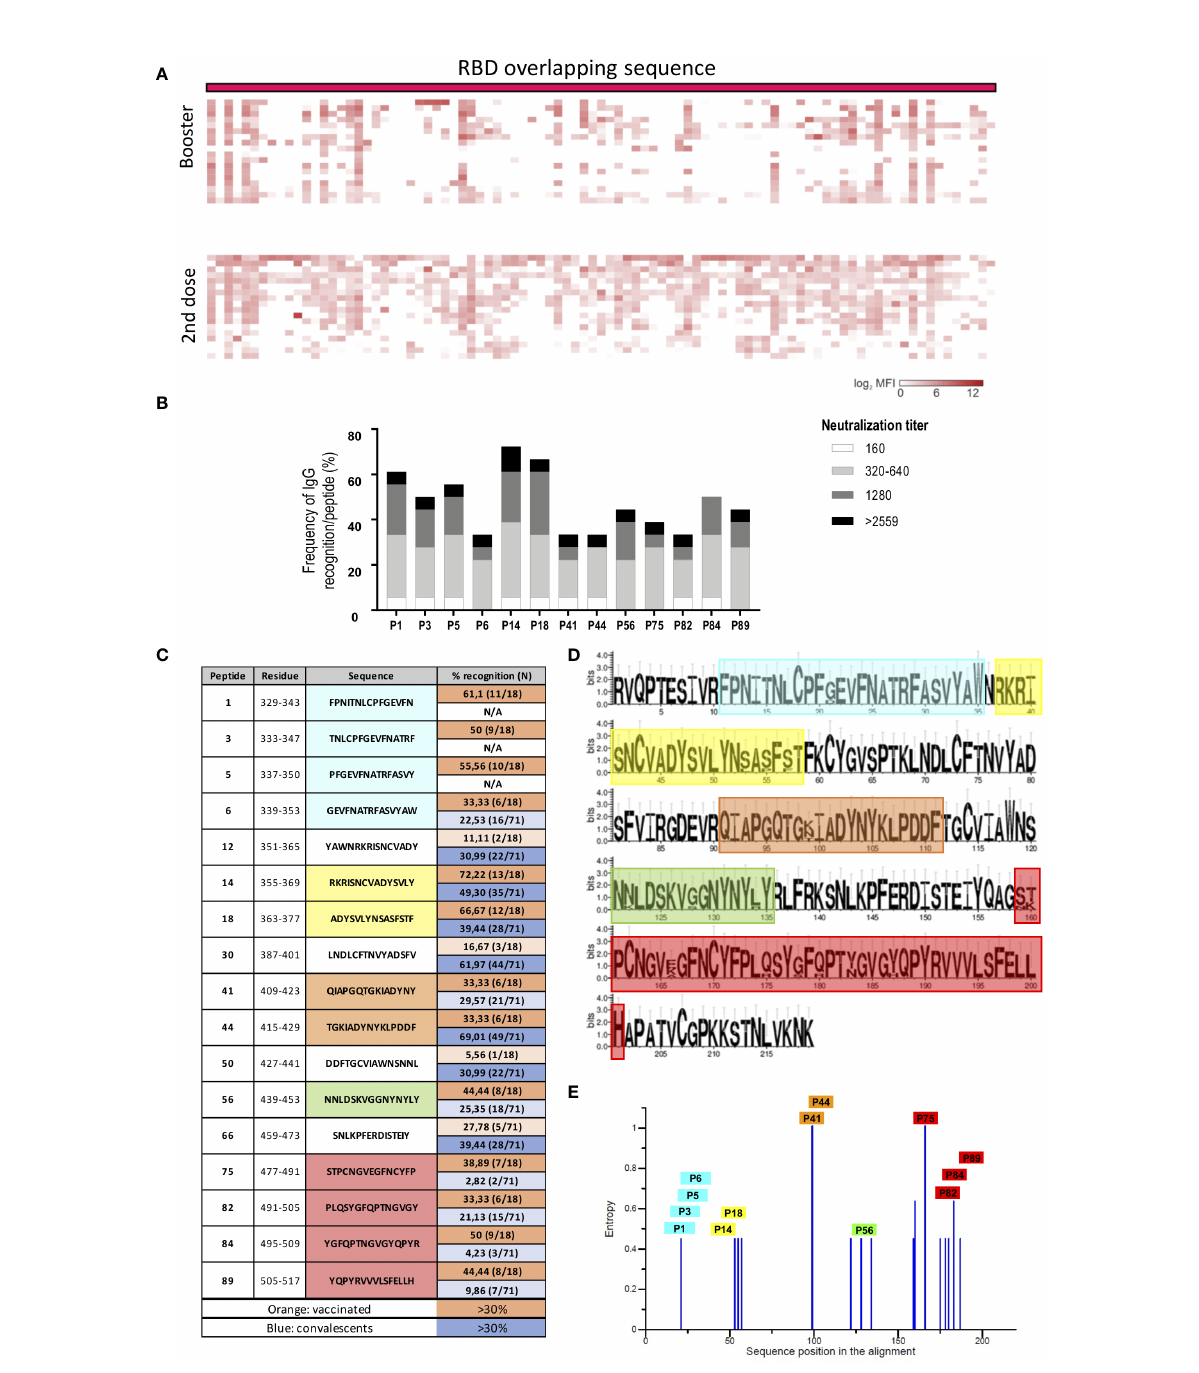
FIGURE 6 RBD peptide recognition pro fi le of vaccinated individuals. (A) Heatmap representing the magnitude of recognition of SARS-CoV-2 RBD peptides tested for IgG reactivity using a peptide microarray (columns: ordered by the primary structure sequence) for all individuals (rows: grouped by vaccine regimen and clustered using median values within each group). 2 nd dose: individuals who received two doses of Coronavac. Booster: individuals who received two doses of Coronavac followed by one dose of MiRNA-273 (Comirnaty). (B) Selected immunodominant peptides recognized by IgG by at least 30% of the individuals in the vaccinated cohort (n=18), showing the total percentage of recognition and neutralization titer ranges. (C) List of top peptides among convalescents or vaccinated. (D) Conservation analysis of the top recognized peptides among RBD proteins from different VOCs (alfa, beta, gamma, delta and omicron BA.1) compared to Wuhan. The height of the letters in the logo plot re fl ects the frequency of the amino acid in the multiple sequence alignment. (E) Entropy of amino acid residues considering the alignment performed, as in D with top peptides